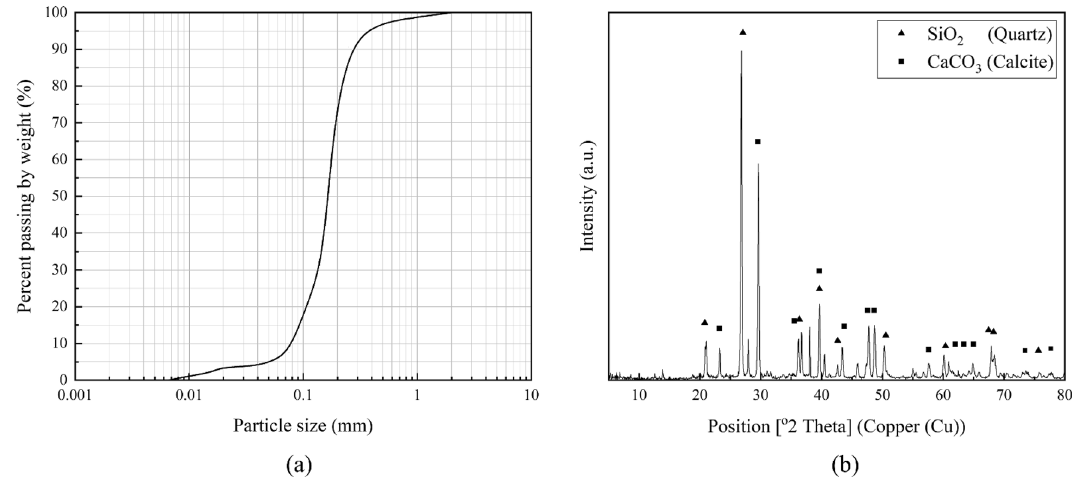
Figure 2. ( a ) Dejgah soil particle size distribution, ( b ) XRD spectra of the Dejgah soil.